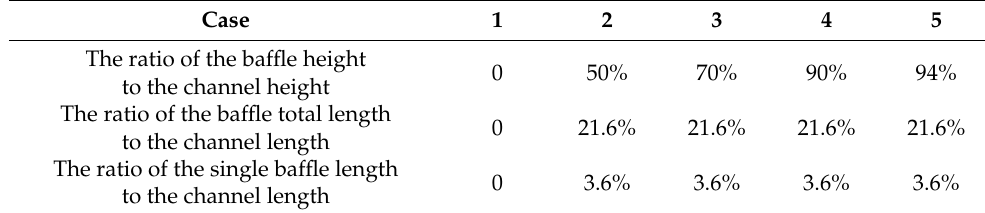
Table 4. Cases under different dimensionless heights of